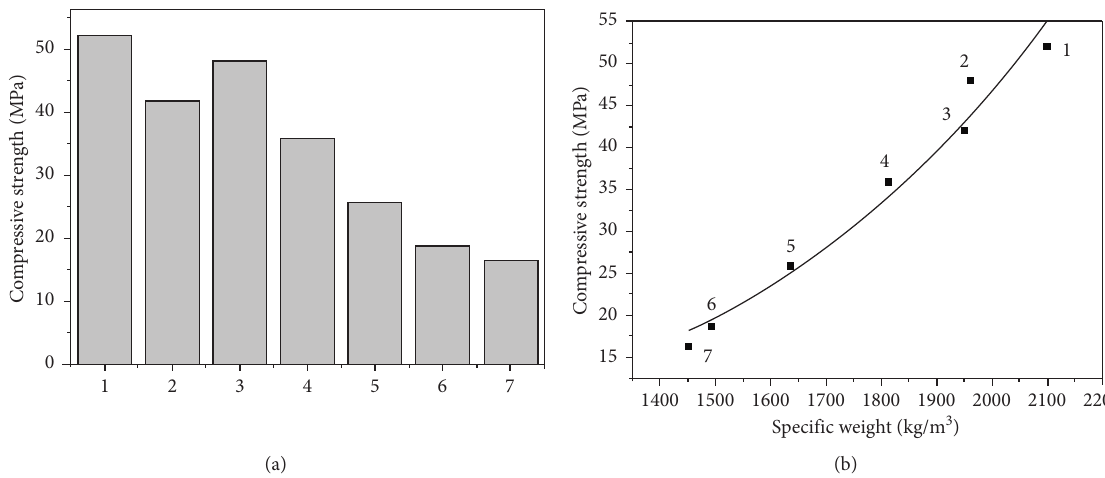
Figure 9: (a) Compressive strength according to tested mixture type; (b) relationship between the compressive strength and specific weight of the